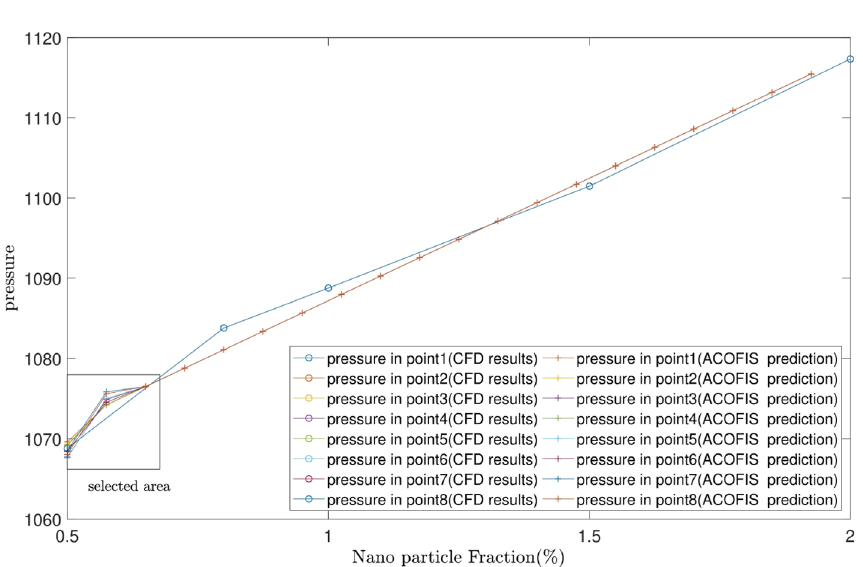
Figure 9. Pattern prediction of pressure in different Nano particle